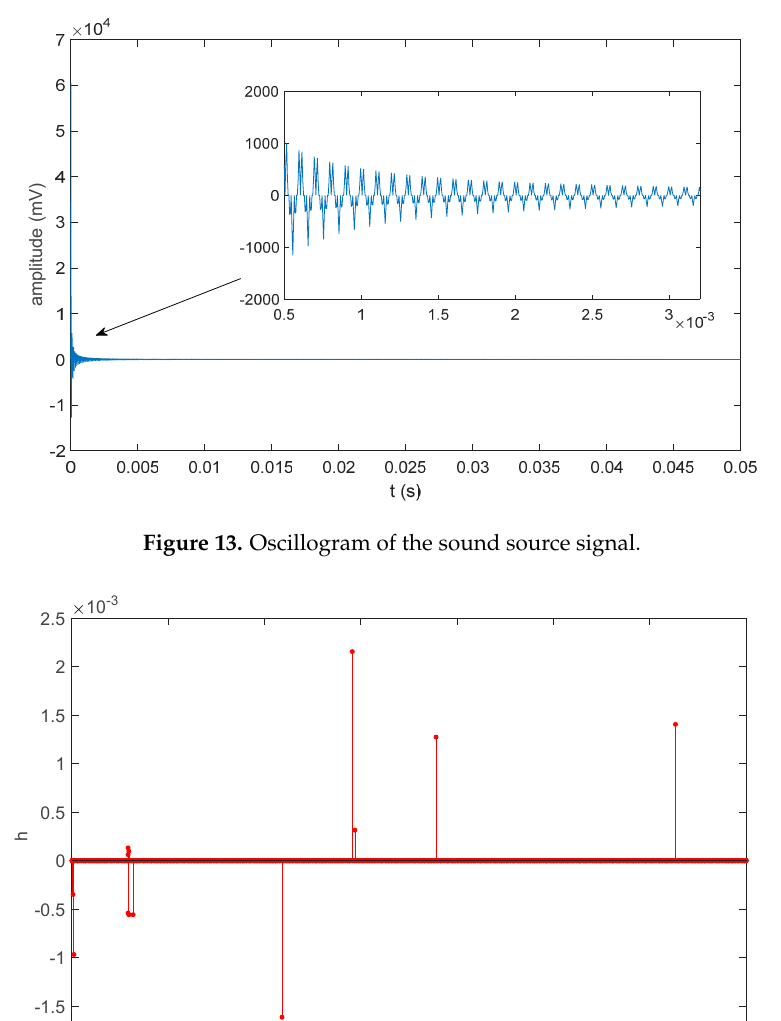
Figure 15. Oscillogram of received signals.